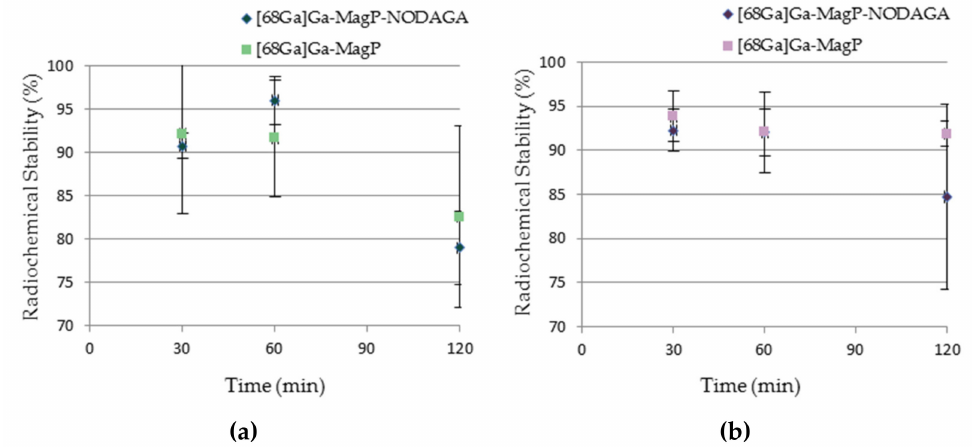
Figure 8. Radiochemical stability of [ 68 Ga]Ga-MIONs in: ( a ) PBS and ( b ) human serum. A statistical difference was found between stability results of [ 68 Ga]Ga-MagP-NODAGA MIONs in PBS at 60 and 120 min ( p < 0.01) and 30 and 120 min ( p < 0.05).